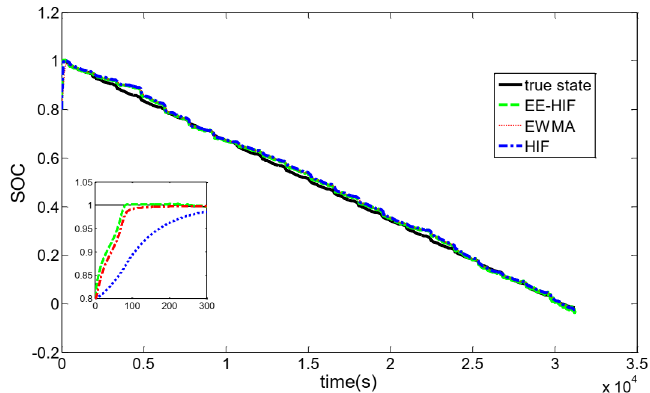
Figure 8. The estimated state curve of the three algorithms.